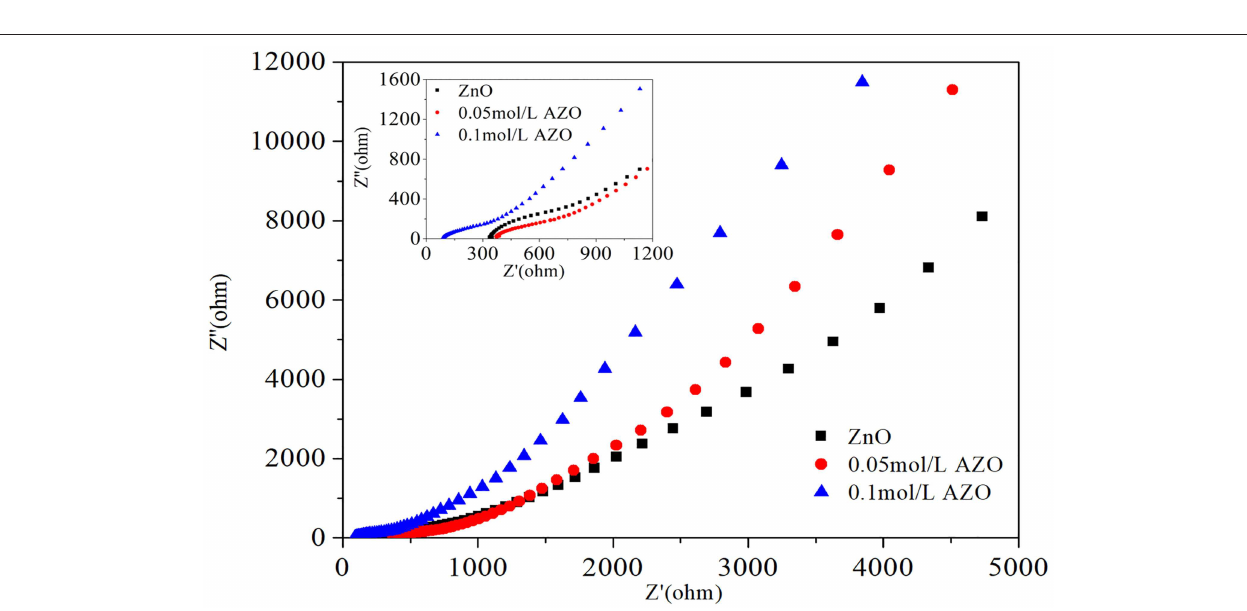
FIGURE 4 | Nyquist plots of 0 mol/L ZnO, 0.05 mol/L AZO, and 0.1 mol/L AZO. Inset is the enlarged high frequency zones.